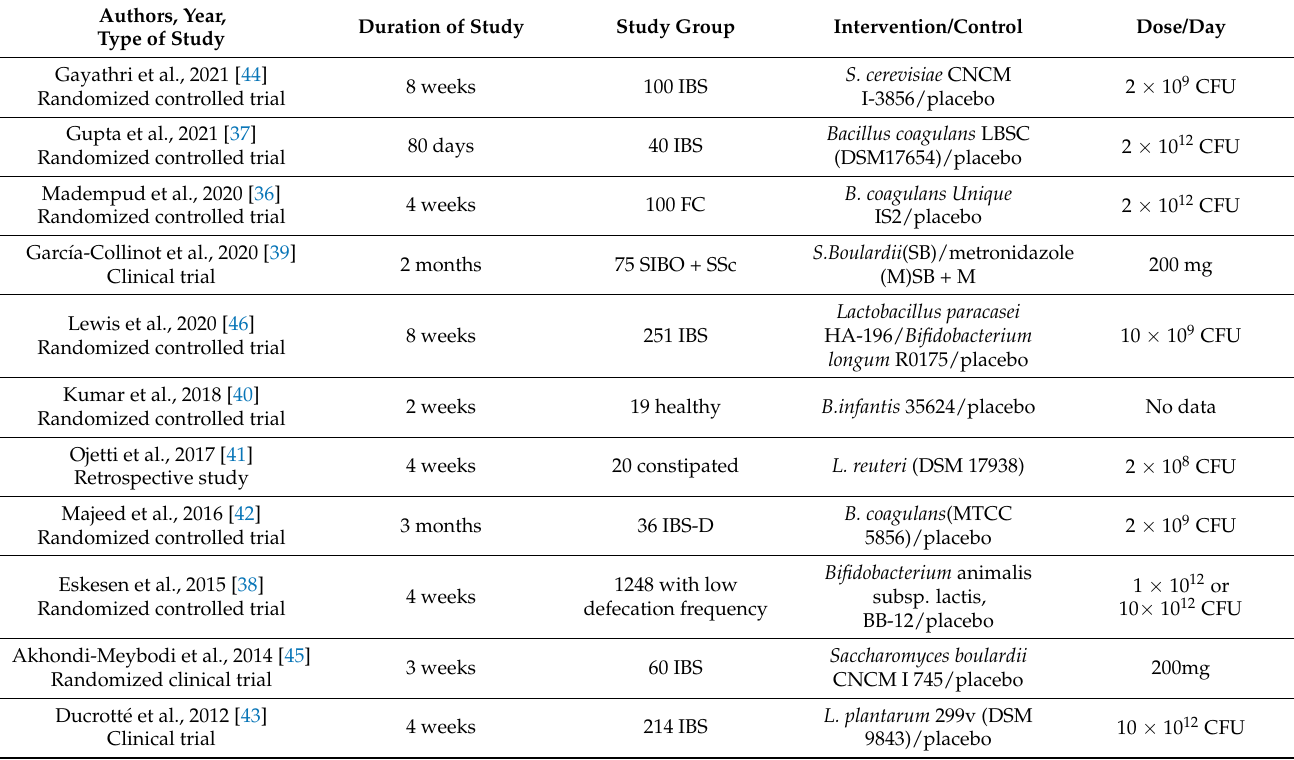
Table 2. Characteristics of included studies connected with monoprobiotics.